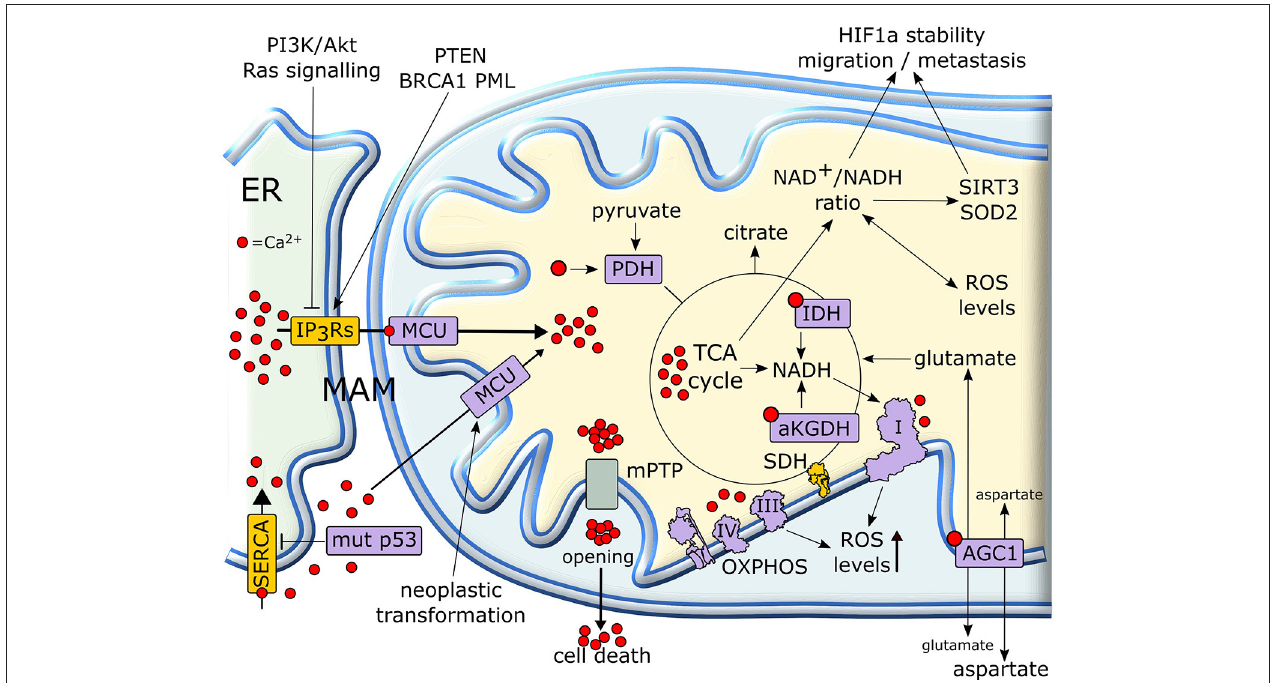
FIGURE 6 | Mitochondrial Ca 2 + in the regulation of tumor cell metabolism. Ca 2 + released from (ER) is taken up by mitochondria, where it increases the activity of TCA cycle and OXPHOS. In cancer cells, a rise in matrix Ca 2 + can stimulate production of metabolic intermediates, glutamate transport and NADH formation for antioxidants defenses. NADH formation can also influence the pro-neoplastic stabilization of HIF1 α . Several proteins with pro- or anti-neoplastic activity regulate IP3R Ca 2 + channels in MAMs in order to prevent matrix Ca 2 + overload, mPTP opening and the consequent cell death. Proteins overexpressed or activated in cancer cells are indicated in purple, whereas proteins whose activity is down-regulated are shown in yellow. ER, endoplasmic reticulum; IP3R, inositol 1,4,5-triphospate receptor; MCU, mitochondrial calcium uniporter; mPTP, mitochondrial permeability transition pore; PDH, pyruvate dehydrogenase; SDH, succinate dehydrogenase; α KGDH, alpha-ketoglutarate dehydrogenase; IDH, isocitrate dehydrogenase; HIF, hypoxia-inducible factor; SERCA, sarco/endoplasmic reticulum Ca 2 +